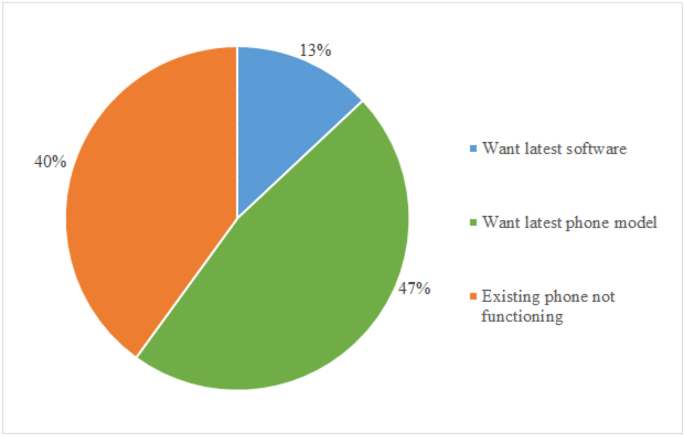
Reasons for smartphone replacement (Watson et al., 2017).